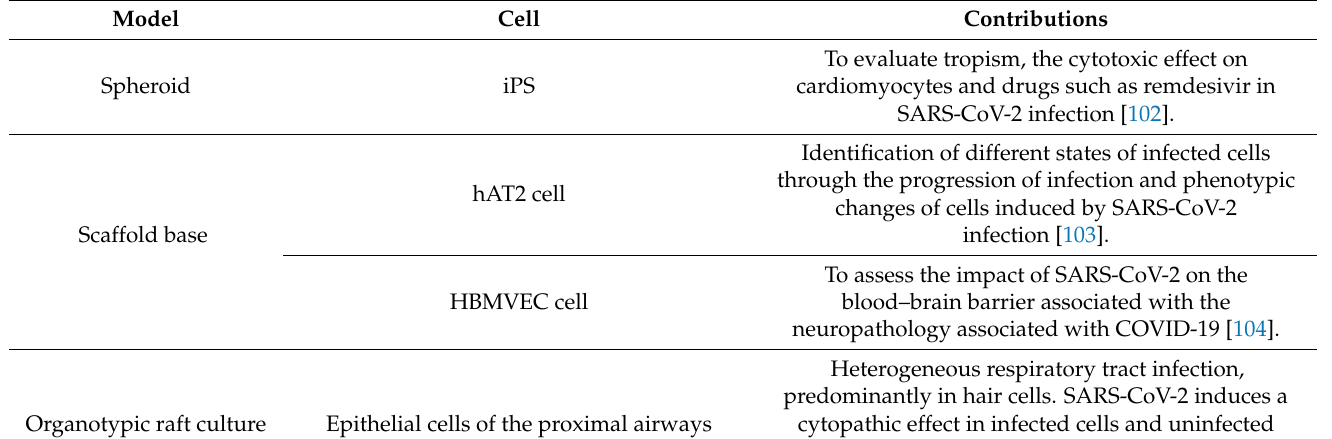
Table 2. 3D models used to study SARS-CoV-2 infection and drug